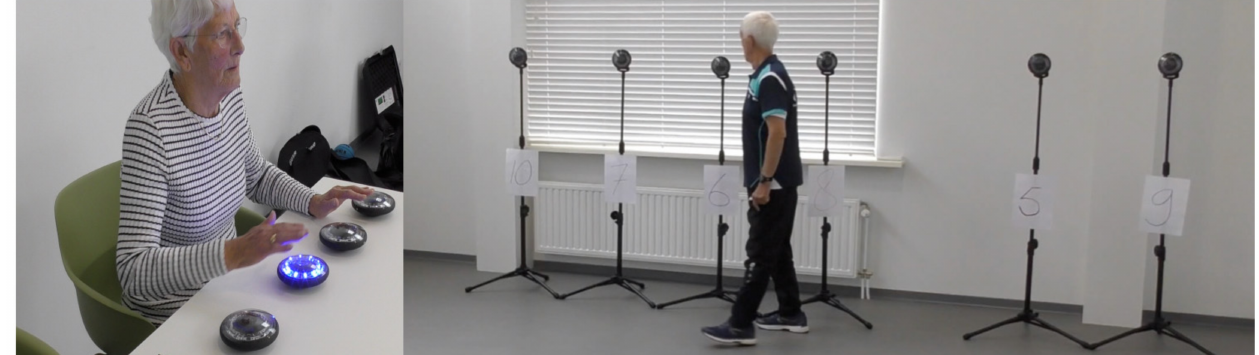
Figure 3. FitLight ® s for testing eyes’ fusion flexibility by the reaction time of saccades from the table redirected to the distant lights and numbers. The specification of this set-up is in Appendix B below.